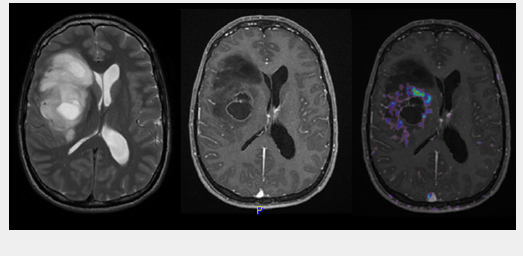
MRI features of right fronto-temporal glioblastoma: T2–weighted MRI (left), T1–weighted MRI with contrast enhancement (middle) and amino acid ( 18 F-ethyltyrosine) PET overlay (right) (courtesy: F. Kuhn, Zurich). On the left, a multifocal, irregular lesion with prominent oedema and mass effect on the lateral ventricle is depicted. In the middle, rim-like contrast enhancement around the necrotic core tumour lesion can be observed. On the right, the PET signal reflects hyper-metabolic areas around this necrotic